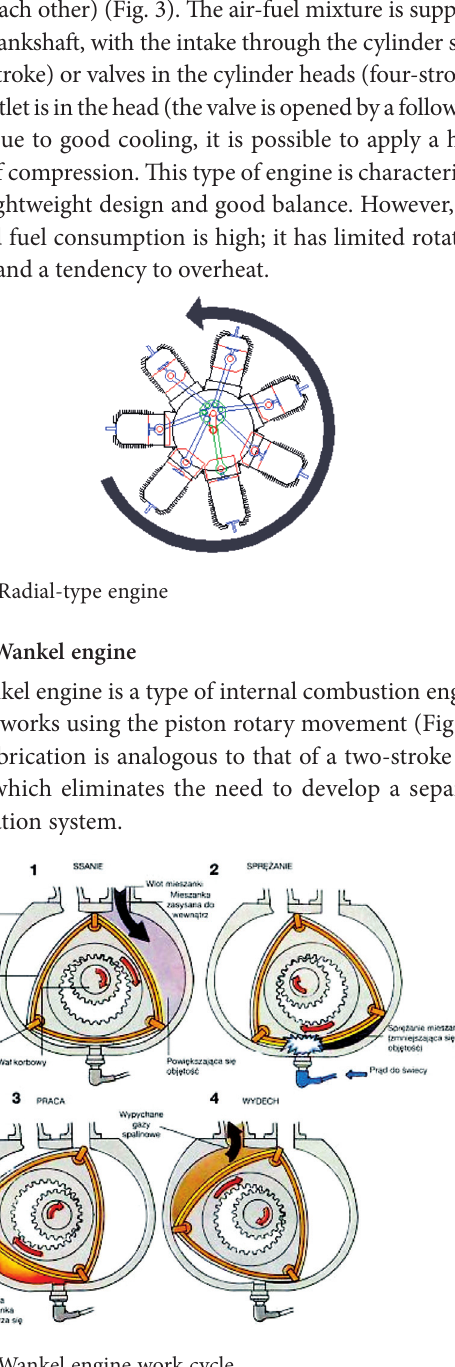
Fig. 4. Wankel engine work